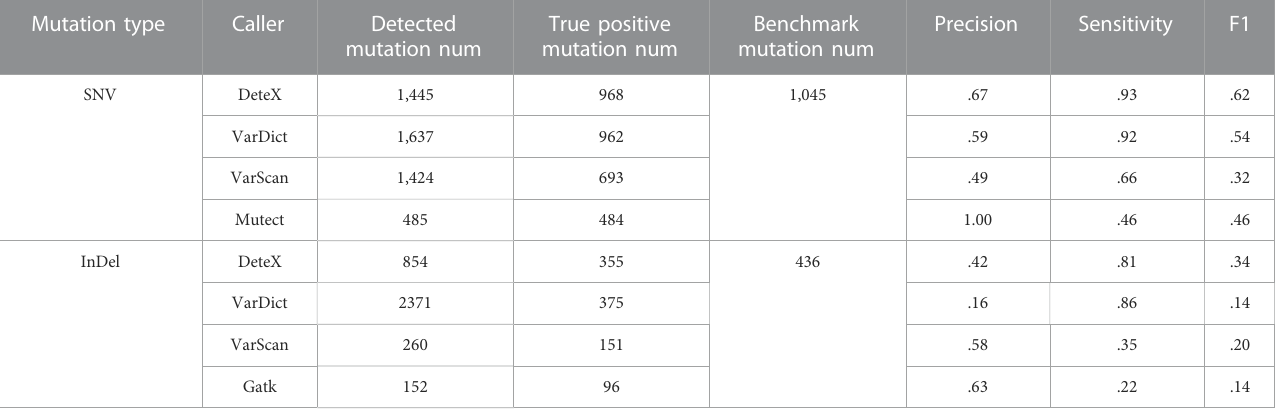
TABLE 2 Results of each caller to detect variants in clinical